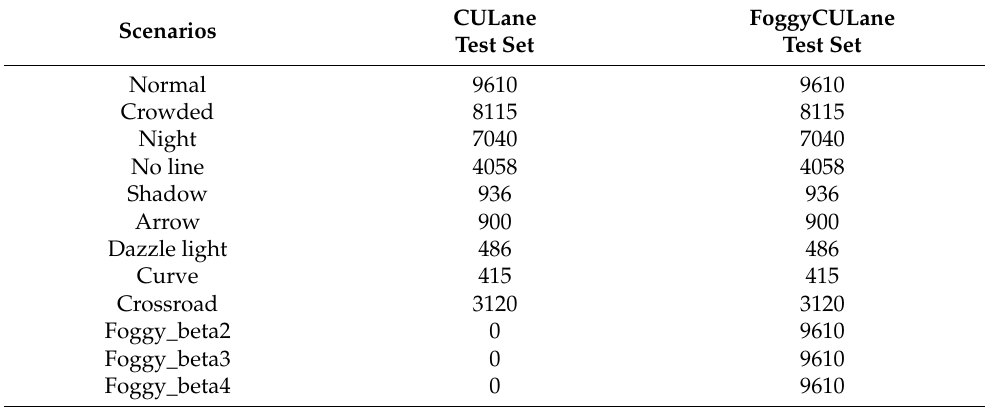
CULane Test Set